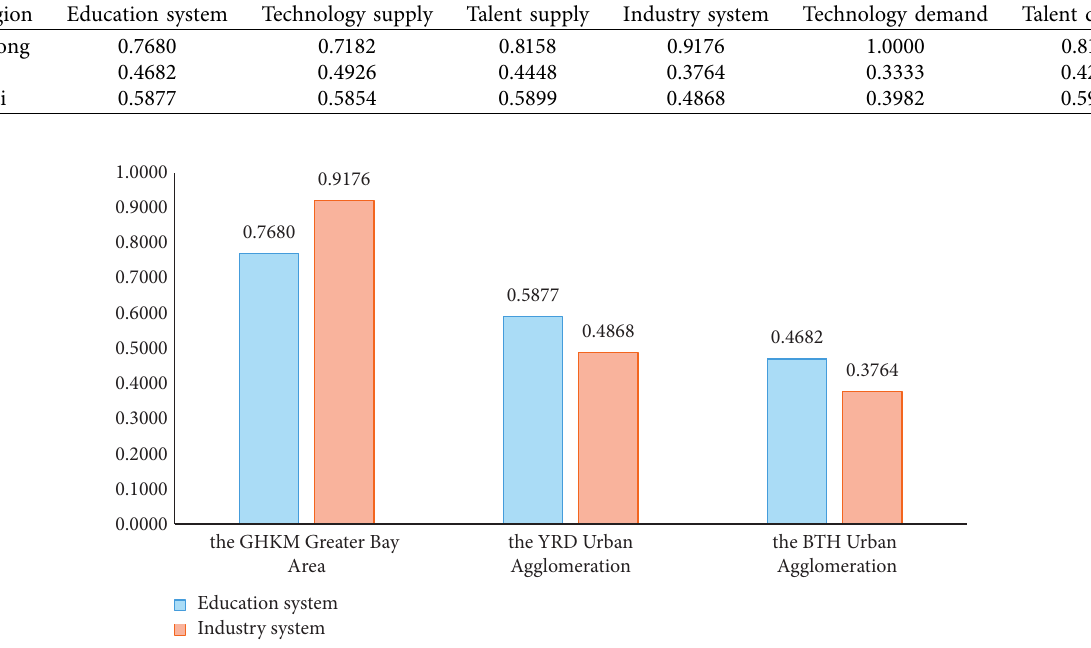
Figure 3: The development levels of two systems in three urban